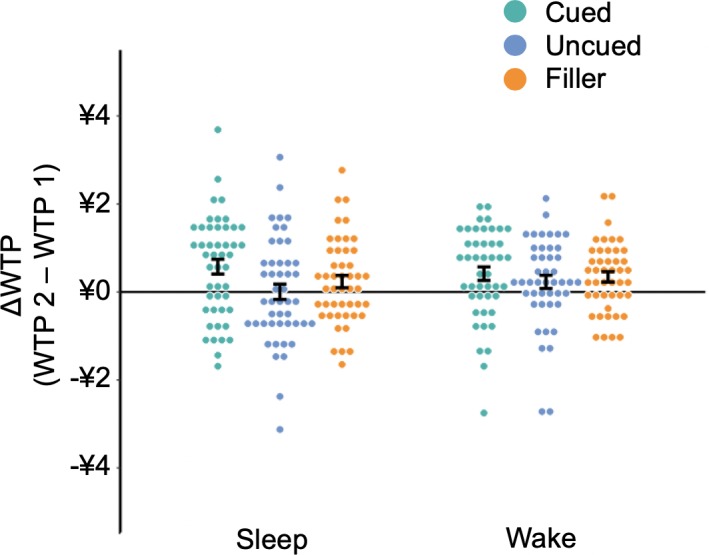
Detailed effects of verbal cueing on ΔWTP.ΔWTP is defined as the paired difference of an item’s WTP before and after the verbal stimulation (i.e., WTP2 – WTP1). Each dot indicates a subject. Dot color represents different types of snack items, including items that had been cued during the verbal stimulation (green), items that had not been cued but matched with cued items and presented in the binary decision task (blue), and items that had neither been cued nor been presented in the binary decision task (orange). When taking filler items (orange) into consideration, repeated measures ANOVA revealed similar results as reported in Figure 2. There was no significant main effect in cohort (sleep vs. wake; F1,90 = 0.085, p = 0.772), yet a significant within-subject main effect in the cueing condition (cued vs. uncued vs. filler: F2,180 = 11.63, p = 1.8 × 10−5), and a significant cohort by condition interaction (F2,180 = 3.07, p = 0.049). Post-hoc analysis showed that ΔWTP was significantly higher for cued relative to other items in the sleep group (cued vs. uncued: t46 = 6.081, p = 6.6 × 10−7; cued vs. filler: t46 = 3.047, = 0.015, Bonferroni corrected), but not in the wake group (cued vs. uncued: t46 = 6.081, p = 0.413; cued vs. filler: t46 = 0.558, p = 1, Bonferroni corrected).